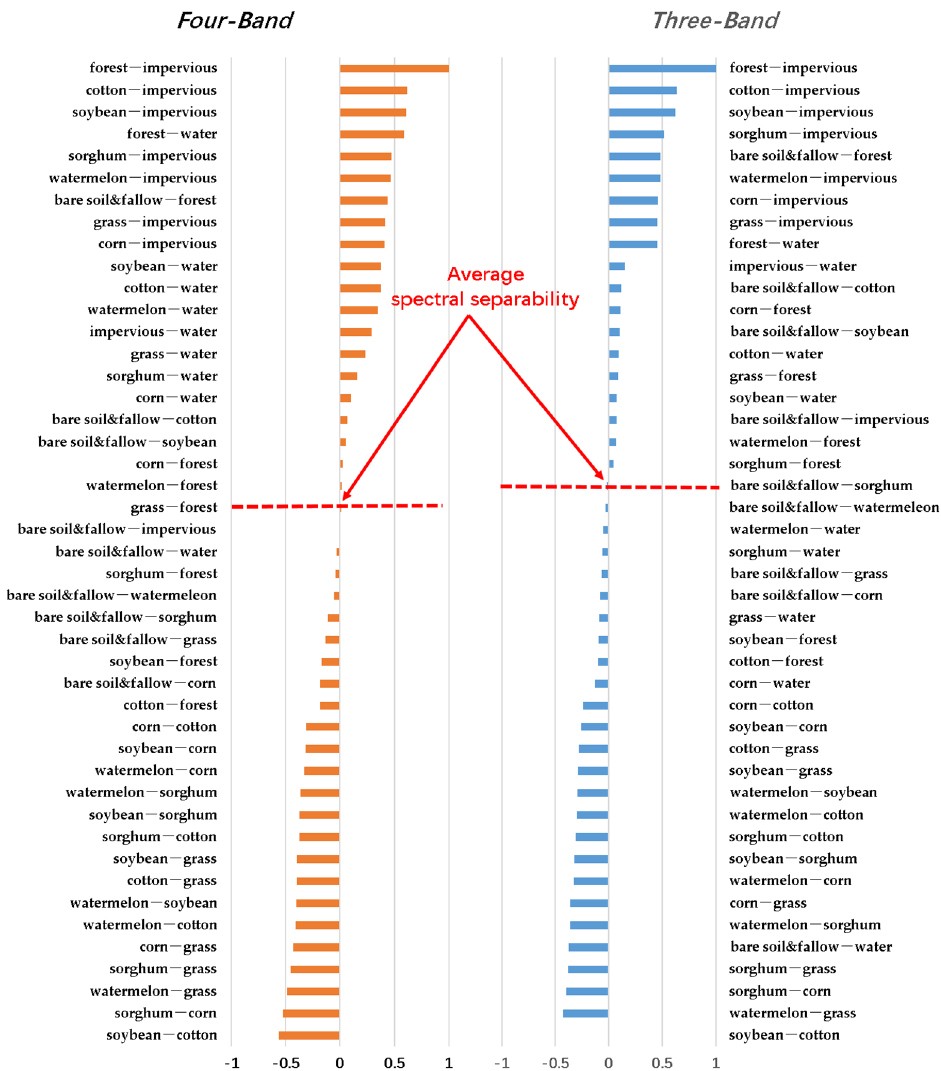
Figure 7. Spectral separability between any two classes for the three-band and four-band images.